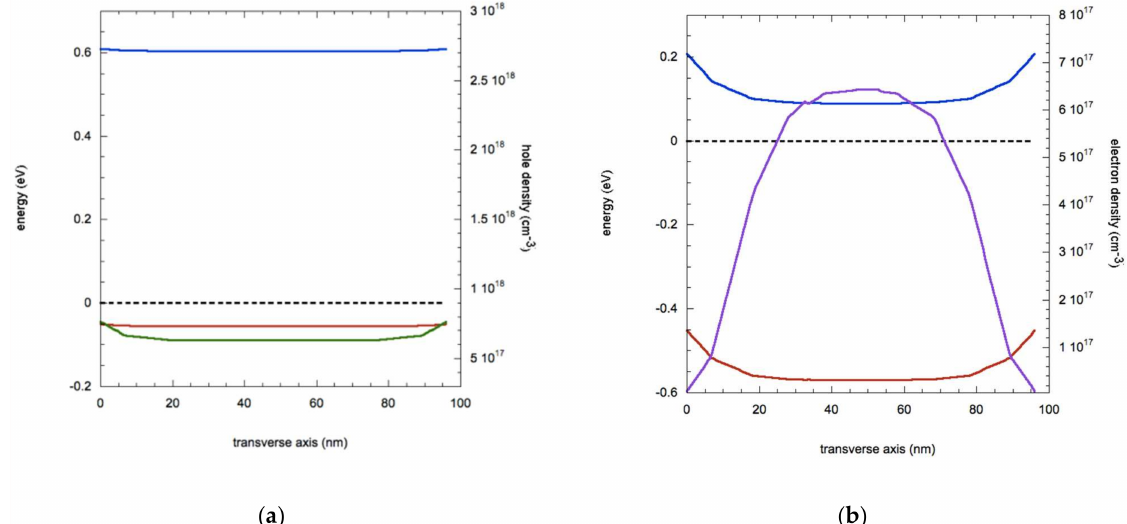
Figure 7. ( a ) Values for energy bands (blue: bottom of conduction band, red: peak of valence band), Fermi level (dashed black line) and hole carrier density (green line) along the transverse axis for a Ge NW with 10 18 cm − 3 hole charge transfer. ( b ) Band profiles (blue: conduction band, red: valence band), Fermi level (dashed black line) and electron carrier density (purple line) along the transverse axis for a Ge NW with 10 18 cm − 3 electron charge